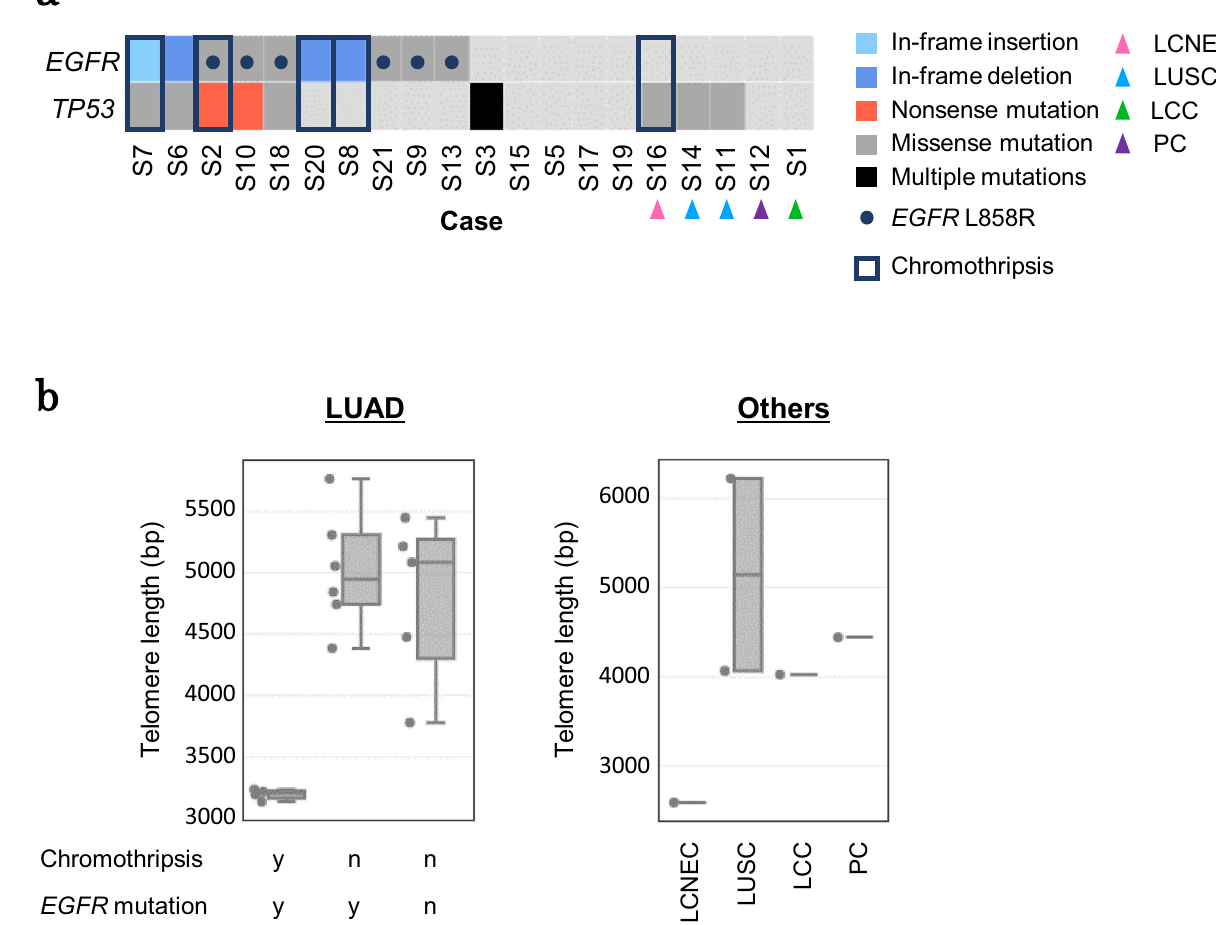
Fig. 7 Characterization of specimens with chromothripsis. a Relationship among mutation statuses and chromothripsis. The legend is provided in the margin. LUAD lung adenocarcinoma, LCNEC large cell neuroendocrine carcinoma, LUSC lung squamous cell carcinoma, LCC large cell carcinoma, PC pleomorphic carcinoma. b Comparison of the telomere length for each tumor type and each chromothripsis event. The ends of the box plots indicate lower and upper quartiles; center line, median; whiskers, maximum and minimum values, respectively. Source data are provided as a Source Data fi le for b